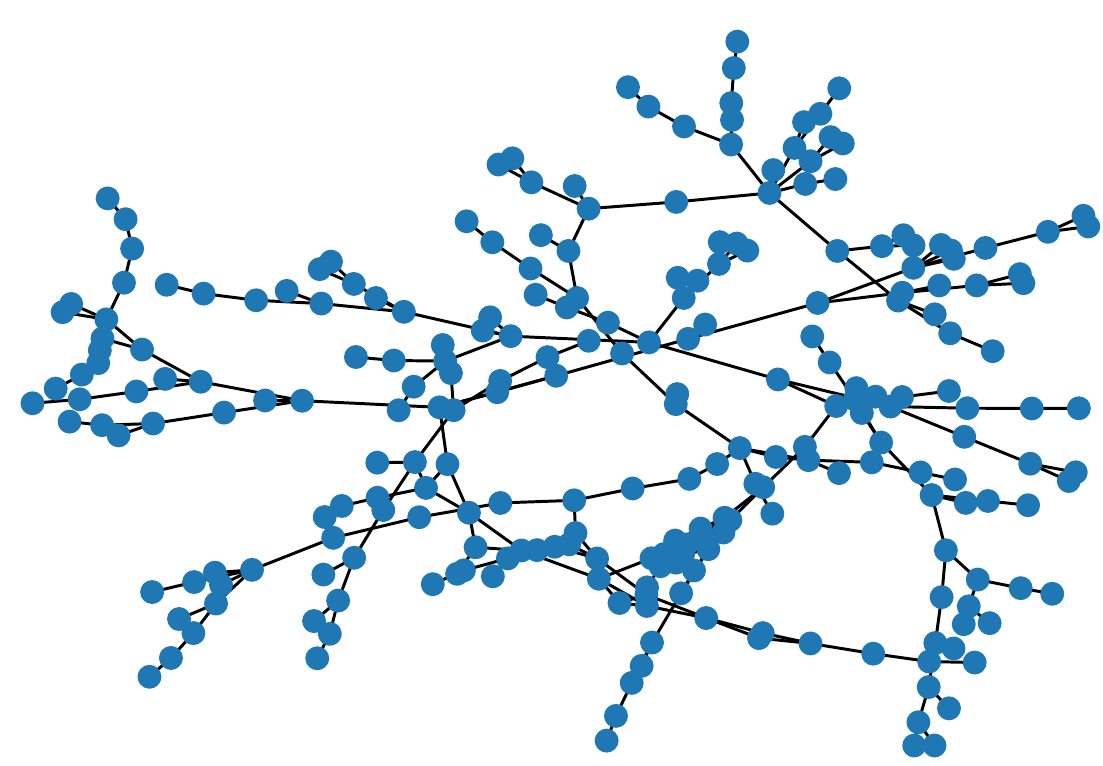
Figure 2. Resulting interconnection network topology.